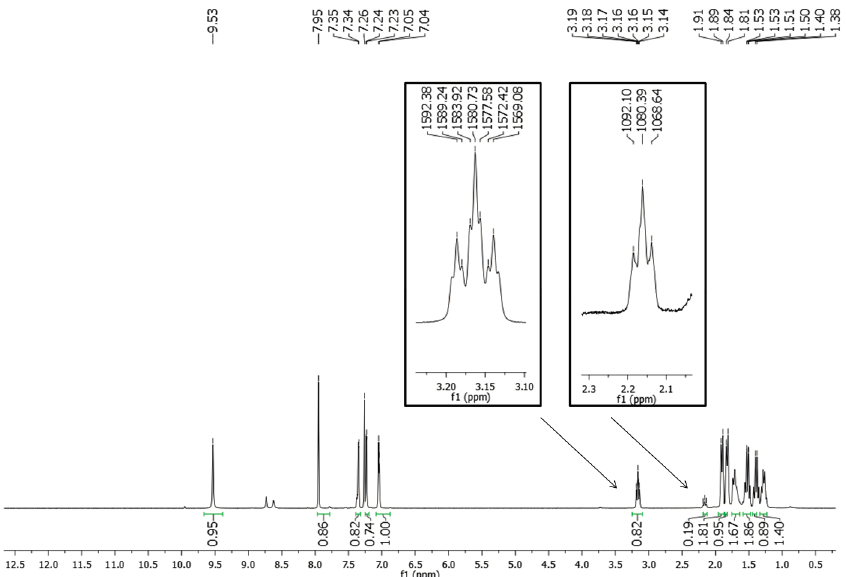
Figure 4. 1 H-NMR (500 MHz, CDCl 3 ) spectrum of NAH derivative 10 with J -coupling of the tertiary hydrogen of the cyclohexyl functionalized system.